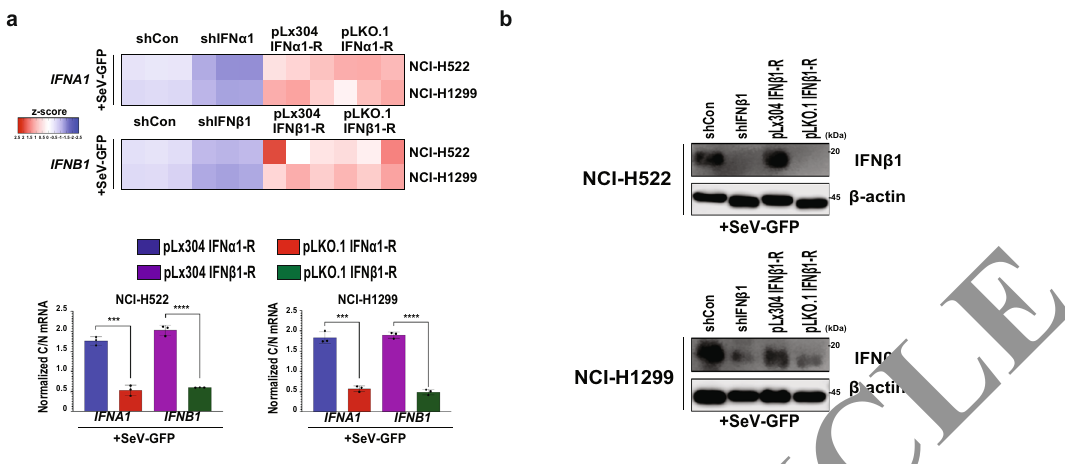
Fig. 4 Type I IFN mRNAs transcribed from an RNA Pol III promoter, fail to exit the nucleus. a Type I IFN mRNAs are transcribed equally well from an RNA Pol II and an RNA Pol III promoter, but only the mRNAs transcribed from the RNA Pol II promoter are exported ef fi ciently to the cytoplasm . (Upper panel) Total RNA was harvested from shControl, sh IFNA1 ( or sh IFNB1) , sh IFNA1 / pLx304-IFN α 1 (or sh IFNB1/pLx304-IFN β 1 ) and sh IFNA1 / pLKO.1-IFN α 1 (or sh IFNB1/pLKO.1- IFN β 1 ) NCI-H522 and NCI-H1299 cells. pLx304-IFNA1 and pLx304-IFNB1 drive IFN α 1 and IFN β 1 expression respectively, from the CMV (RNA Pol